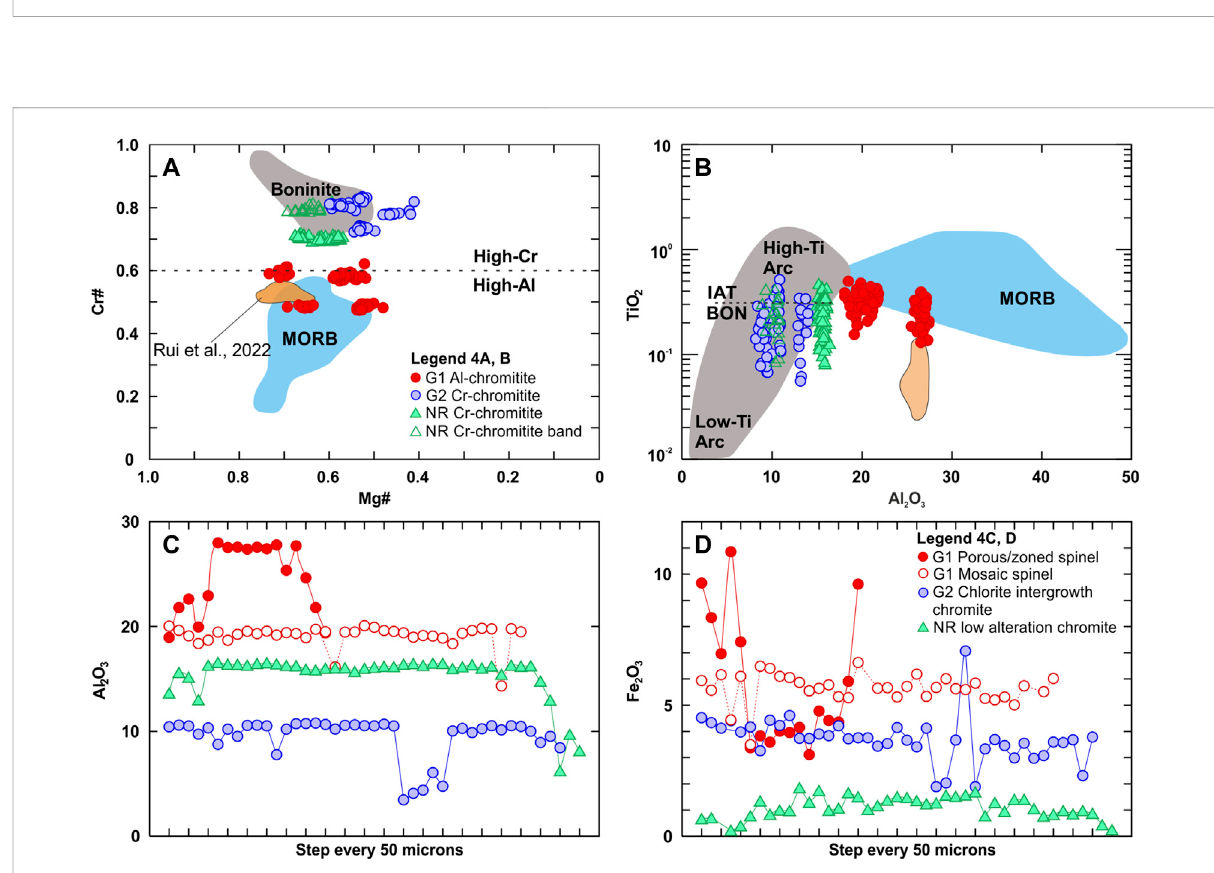
FIGURE 4 Plots of spinel core analyses from the studied chromitites: (A) Cr# vs. Mg#. (B) LogTiO 2 vs. Al 2 O 3 ; Analyses conducted in traverses in texturally different grains. (C) Al 2 O 3 distribution. (D) Fe 2 O 3 distribution. Fields after Kamenetsky et al. (2001). Abbreviations: IAT = island arc tholeiites; BON = boninites; MORB = mid-ocean ridge